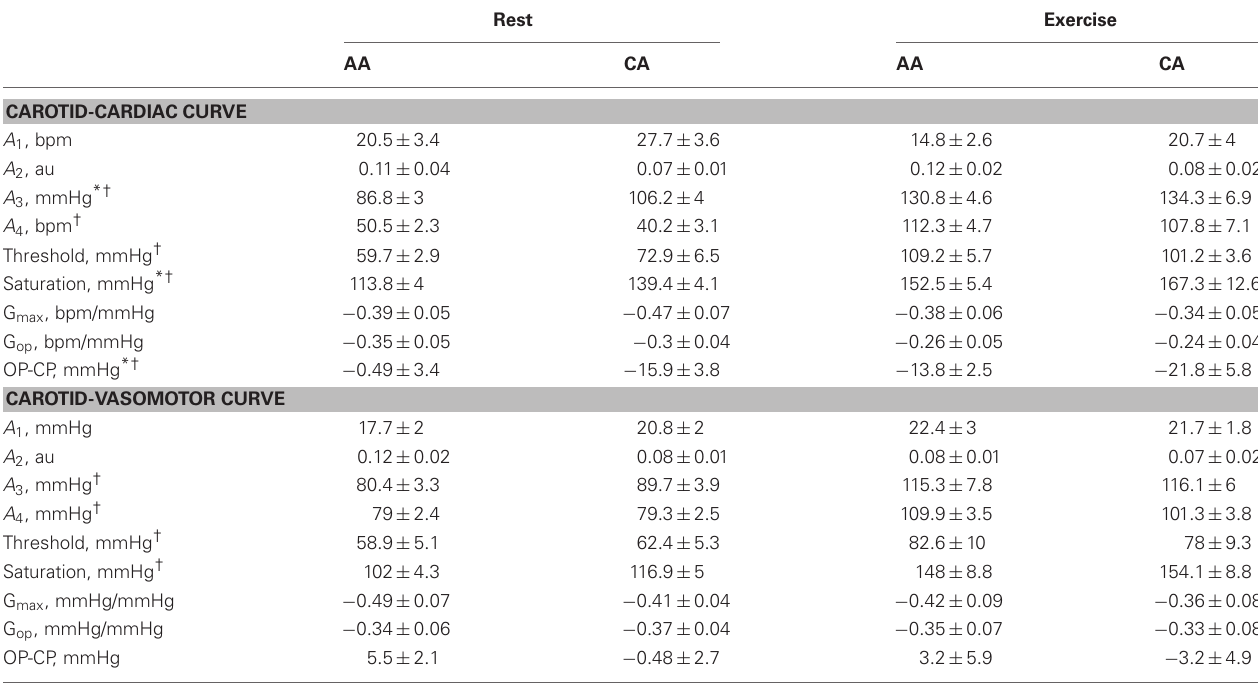
Table 2 | Logistic model parameters and derived parameters. Rest Exercise AA CA AA CA CAROTID-CARDIAC